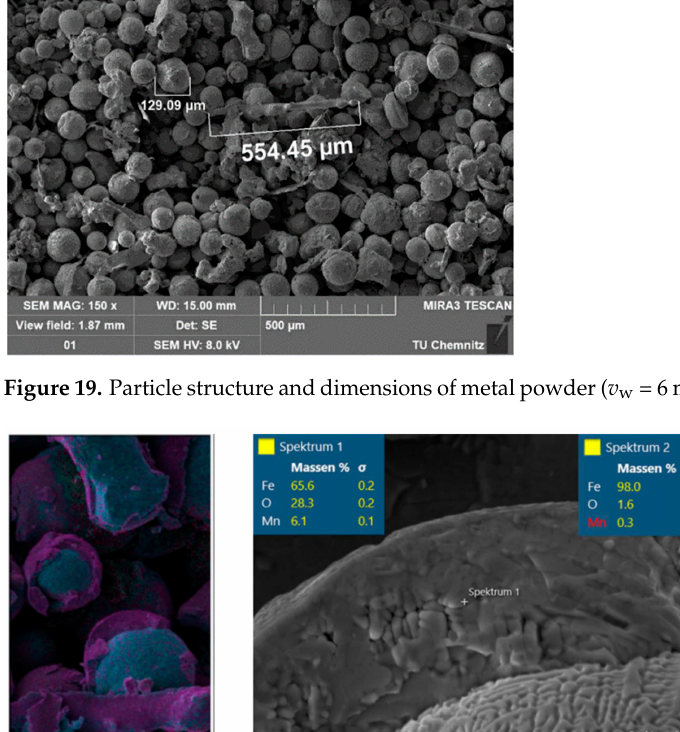
Figure 20. Element distribution in the